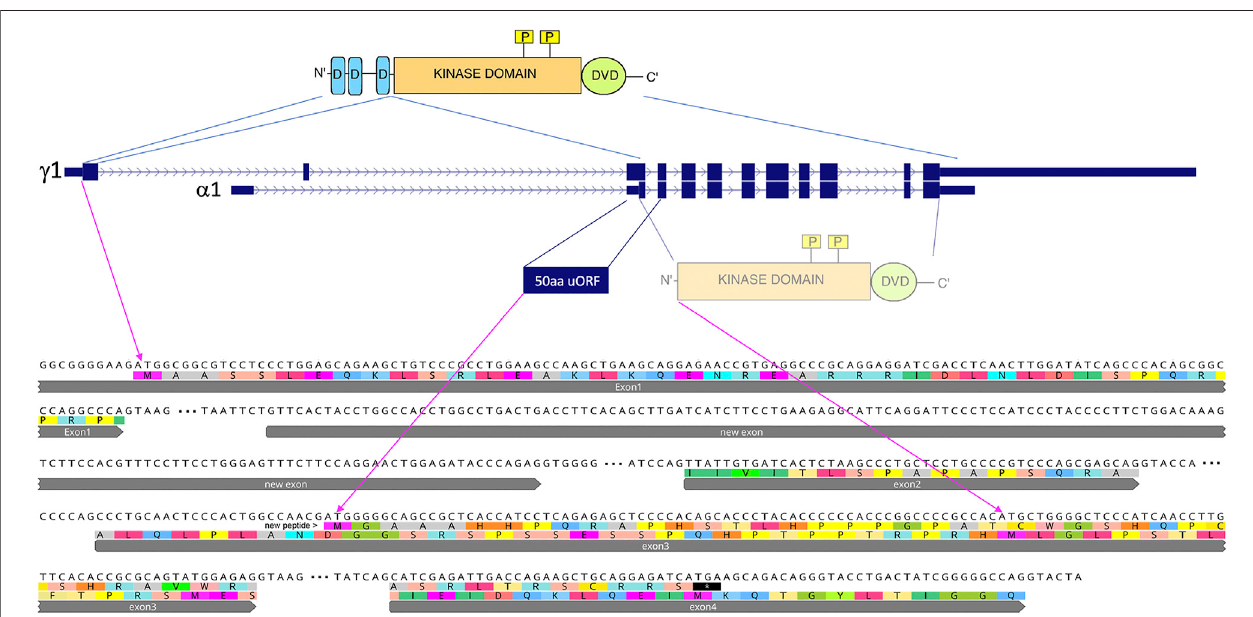
FIGURE3| Comparison ofthemain Map2k7 transcriptsandtheircodingpotentials. TranscriptdepictionsaretakenfromtheUCSCbrowserannotations(seealso Figure 2 ), whereby only the two main transcripts are shown, the conserved one ( γ 1) and the new one starting from the new promoter ( α 1). The protein domains of the Map2k7 functional kinase are depicted on the top, including the JNK-binding sites (D-domains in blue), the kinase domain (in orange) with its functional phosphorylation sites (yellow), aswellasthe C-terminalDVD domain (green).The fi rstAUG inthe newtranscriptisinthethird exon,and ithas a50aaORF, whichwould representa denovo generatedprotein.IfthisAUGwould notbeused,thenextAUGinadifferentframecouldpotentiallyleadtotheexpression ofatruncated versionofthe Map2k7 protein, containing only the kinase and the DVD domains. The corresponding coding exon sequences (up to exon 4 for the γ 1 transcript) are depicted below ( fl anked by their splice sites, introns are depicted as three dots) with the translations in the two alternative reading frames.